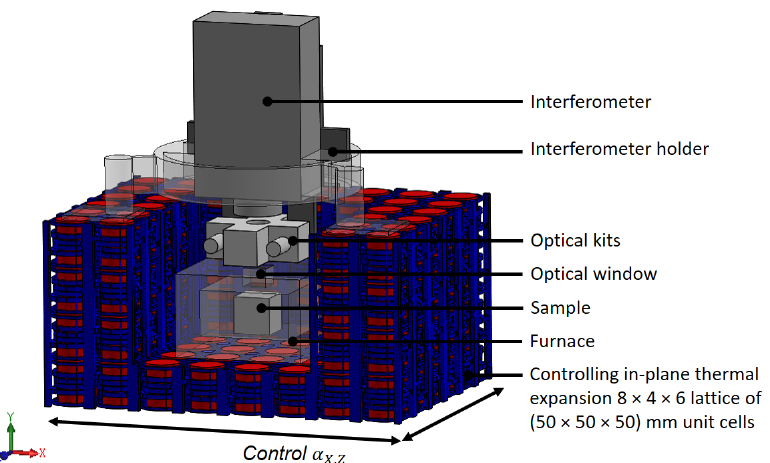
Figure 1. Illustration of precision measurement equipment with the 8 × 4 × 6 lattice; an optical vertical dilatometer.